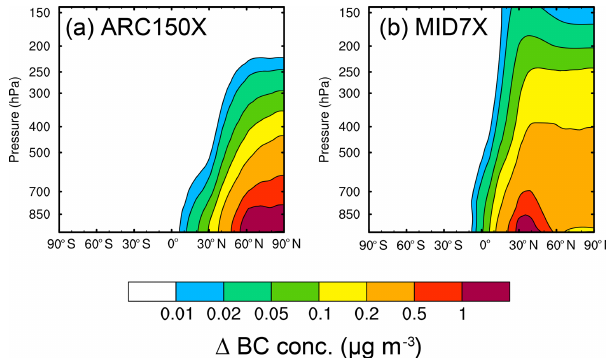
Figure 1. Difference in annual and zonal-mean BC concentrations (µgm − 3 ) between ARC150X (a) , MID7X (b) , and PD